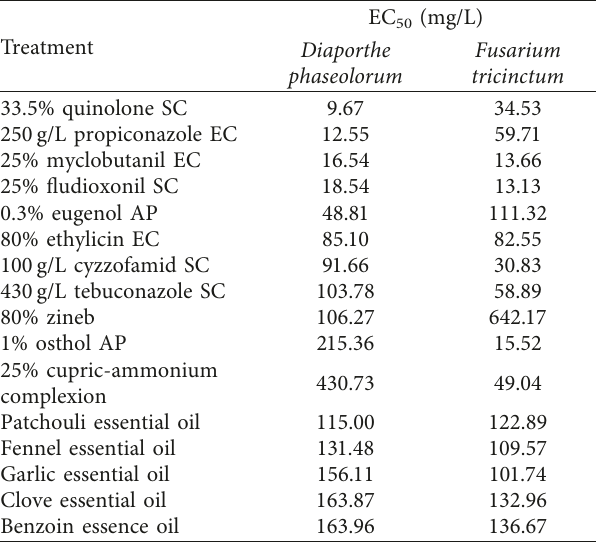
Table 1: The EC 50 values of the test fungicides and plant essential oils against Diaporthe phaseolorum and Fusarium